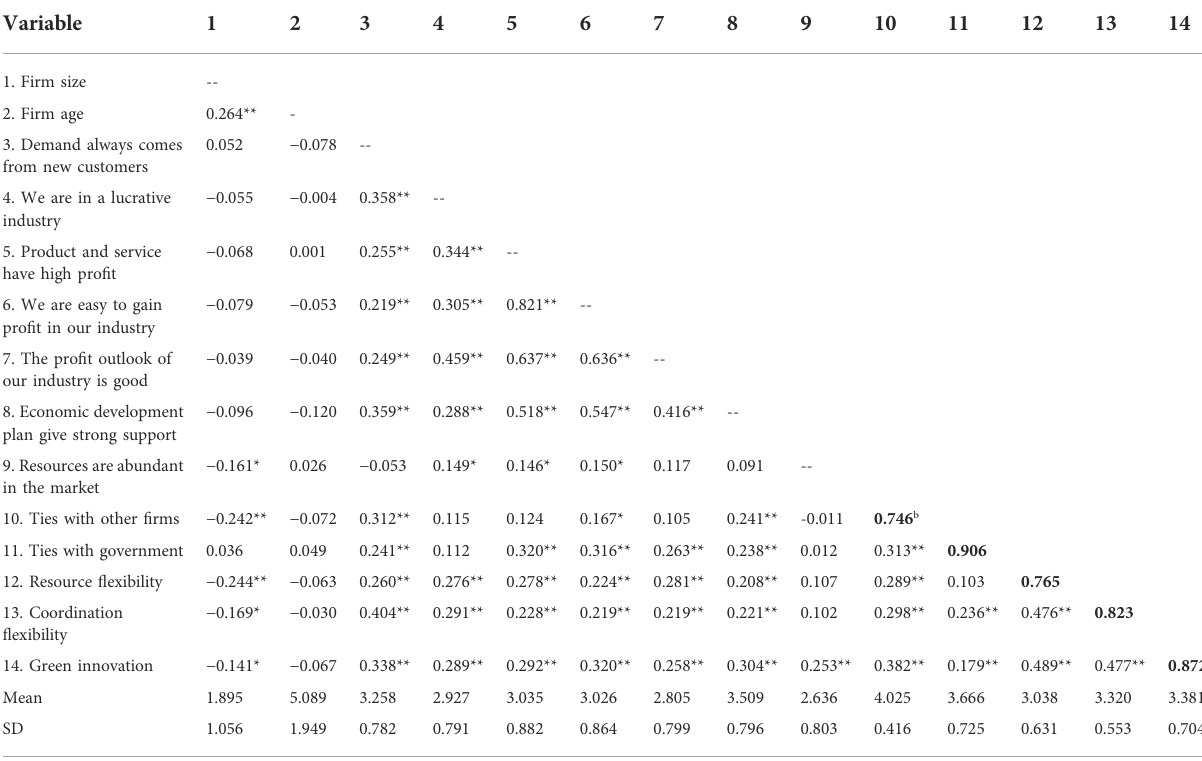
TABLE 2 Descriptive Statistics and Correlation Matrix a .